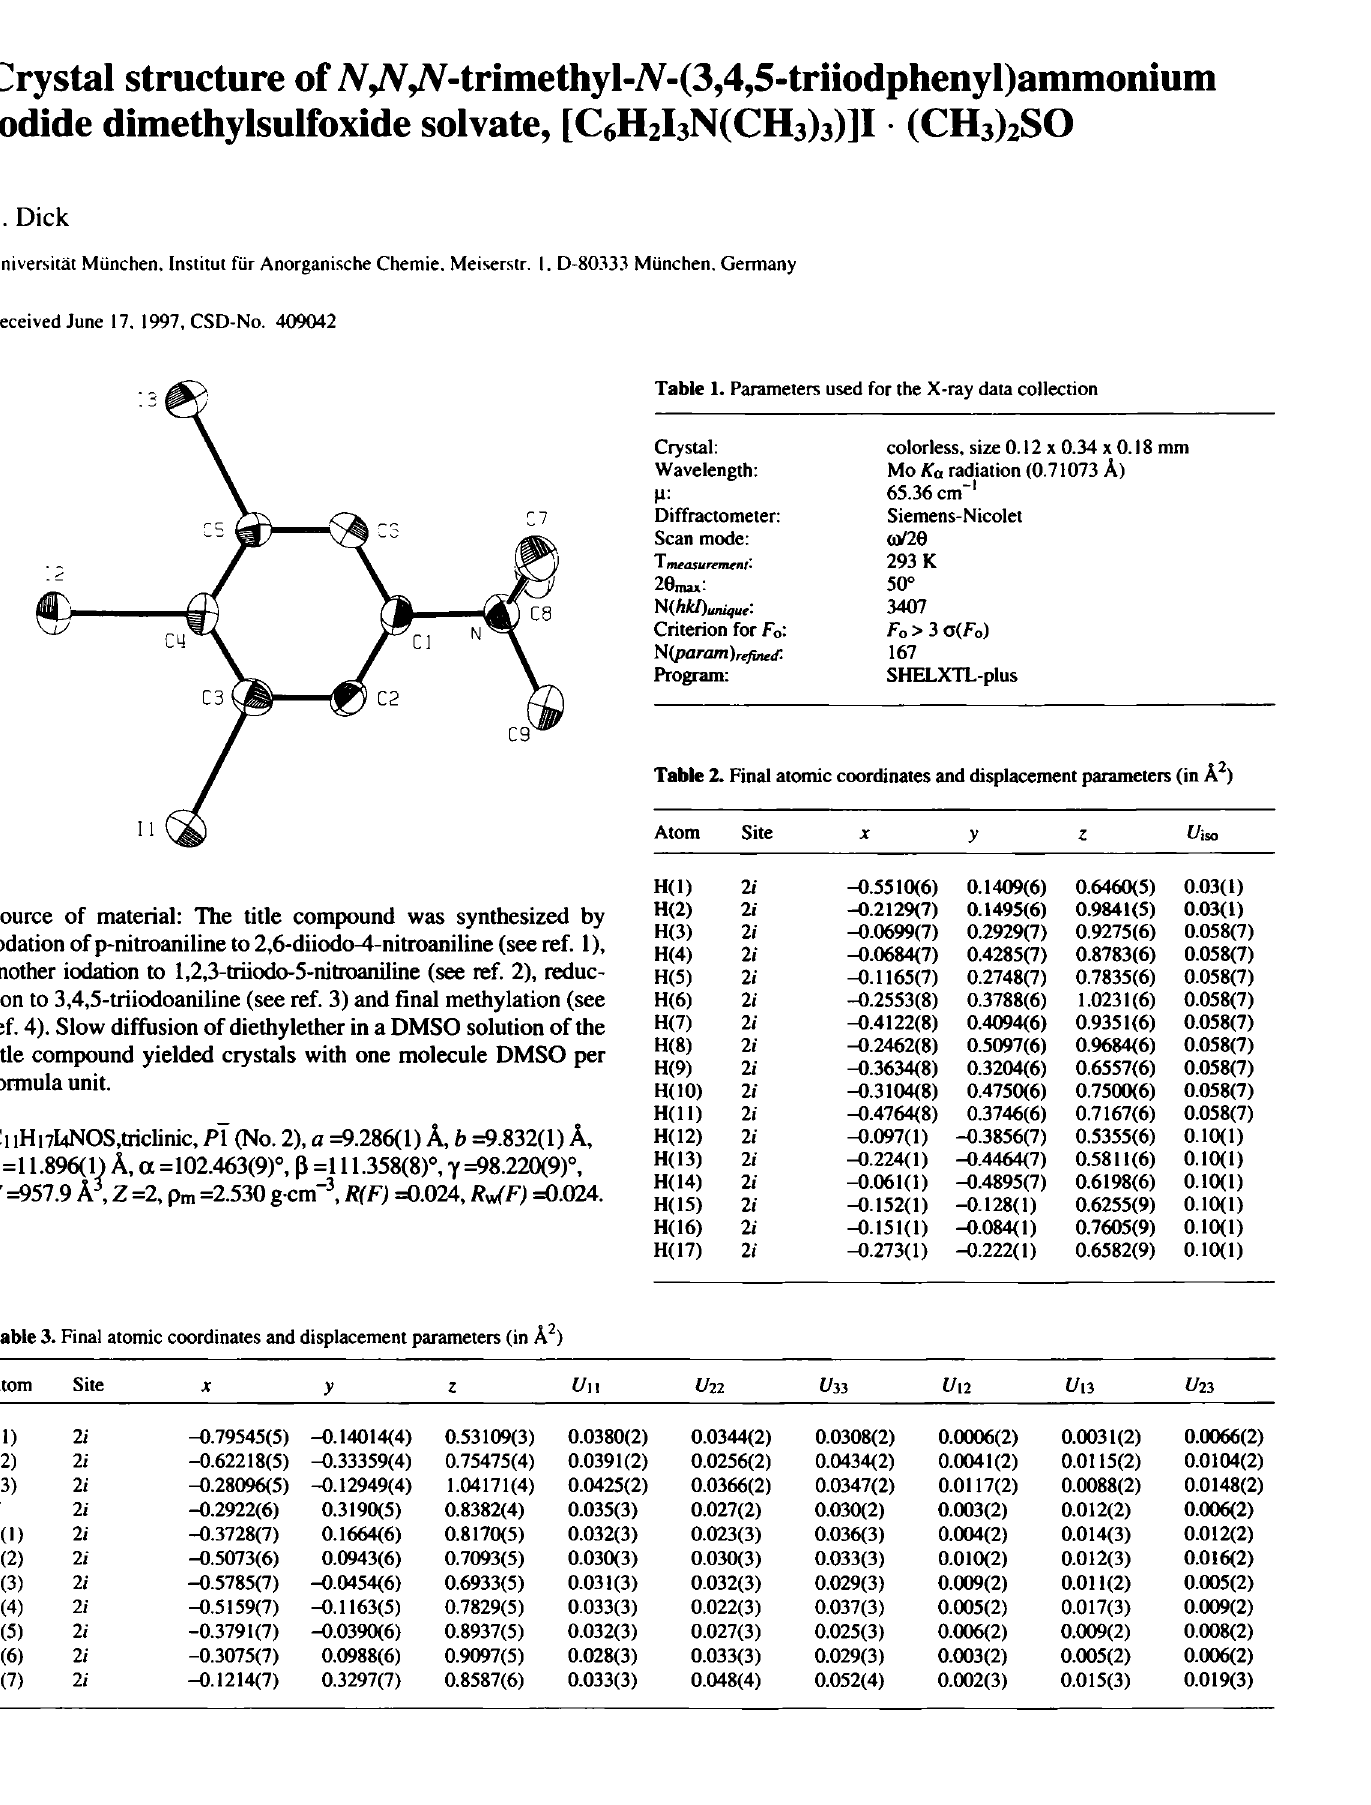
Table 3. Final atomic coordinates and displacement parameters (in A^) Atom Site